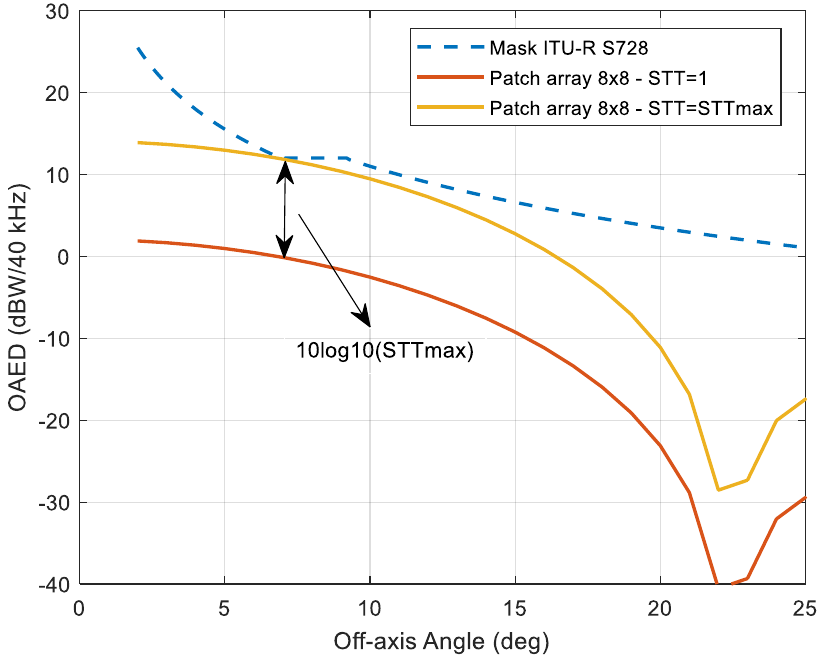
Figure 19. UC#3 OAED constraint.